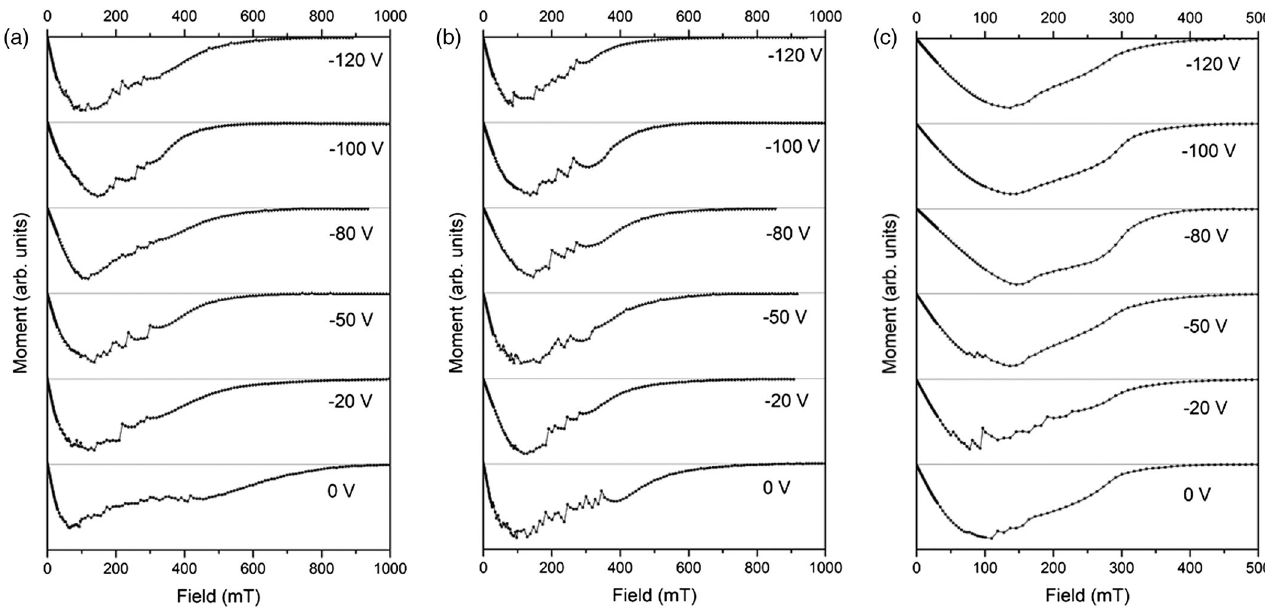
FIG. 1. dc magnetic moment against applied magnetic field at 4.2 K for niobium samples which were deposited at (a) room temperature, (b) 500 °C and (c) 700